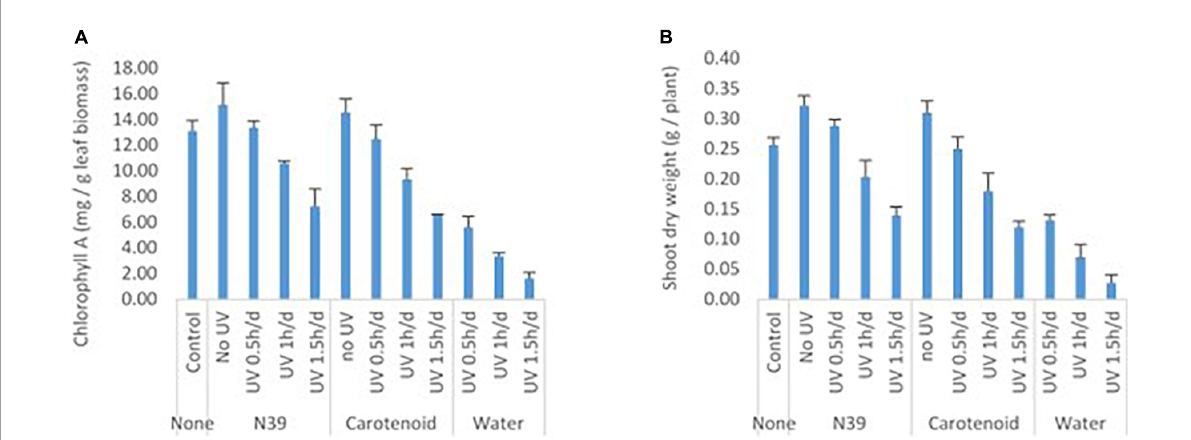
FIGURE8 Effect of foliar application of cells of Methylobacter sp N39 and carotenoid on plant’s UV resistance. The test plant Pigeon pea ( Cajanus cajan var Asha) was grown under controlled condition. On 30th day of sowing, plants were subjected to foliar application of Methylobacter sp N39 (10 6 cells/ml), carotenoids extracted (10 µ g/ml) from Methylobacter sp N39, and water as control. The treated plants were UV irradiated for 0.5, 1, and 1.5 h per day for 3 consecutive days. On 40th day of sowing, plants were analyzed for (A) chlorophyll A content and (B) shoot dry weight. X -axis represents treatments and Y -axis represents parameters. Values are presented as arithmetic mean with error bar as standard deviation of three replicated observations.